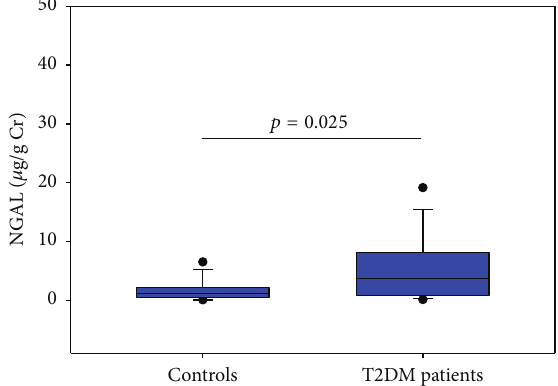
Figure 3: Plot showing the median (line within box), 25th and 75th percentiles (box), 5th and 95th percentiles (whiskers), and outliers ( ∙ ) of neutrophil gelatinase-associated lipocalin (NGAL) levels, normalized for creatinine (Cr) content, in the controls group and in T2DM patients. Differences with 𝑝 values < 0.05 were considered statistically